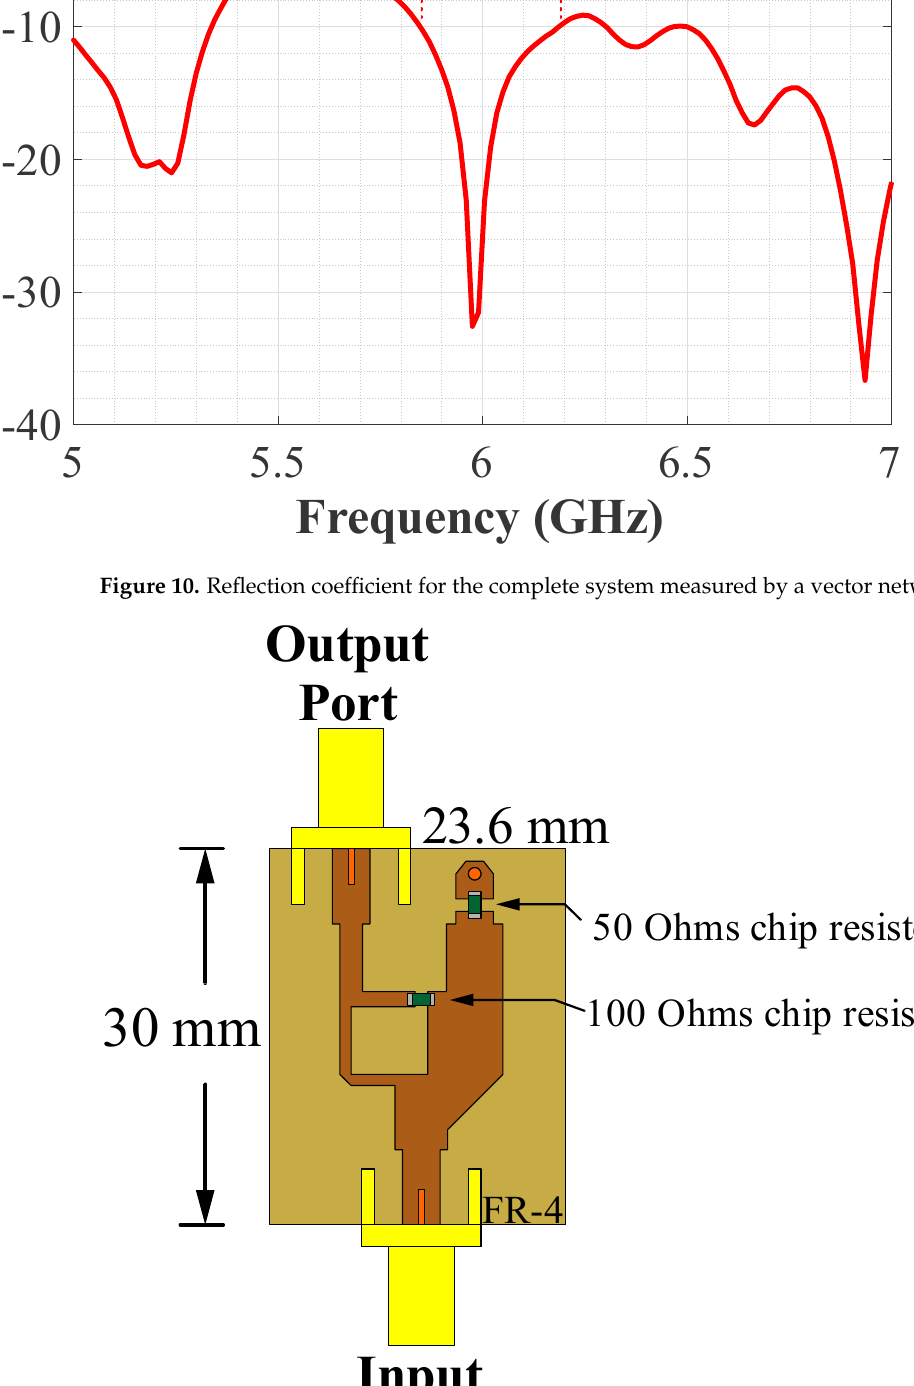
Figure 11. Example of the schematic diagram for the attenuators.